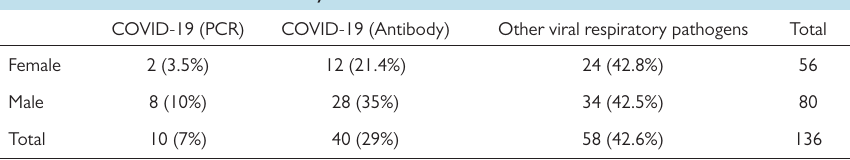
Table 3. Distribution of the Results by Sex COVID-19 (PCR)